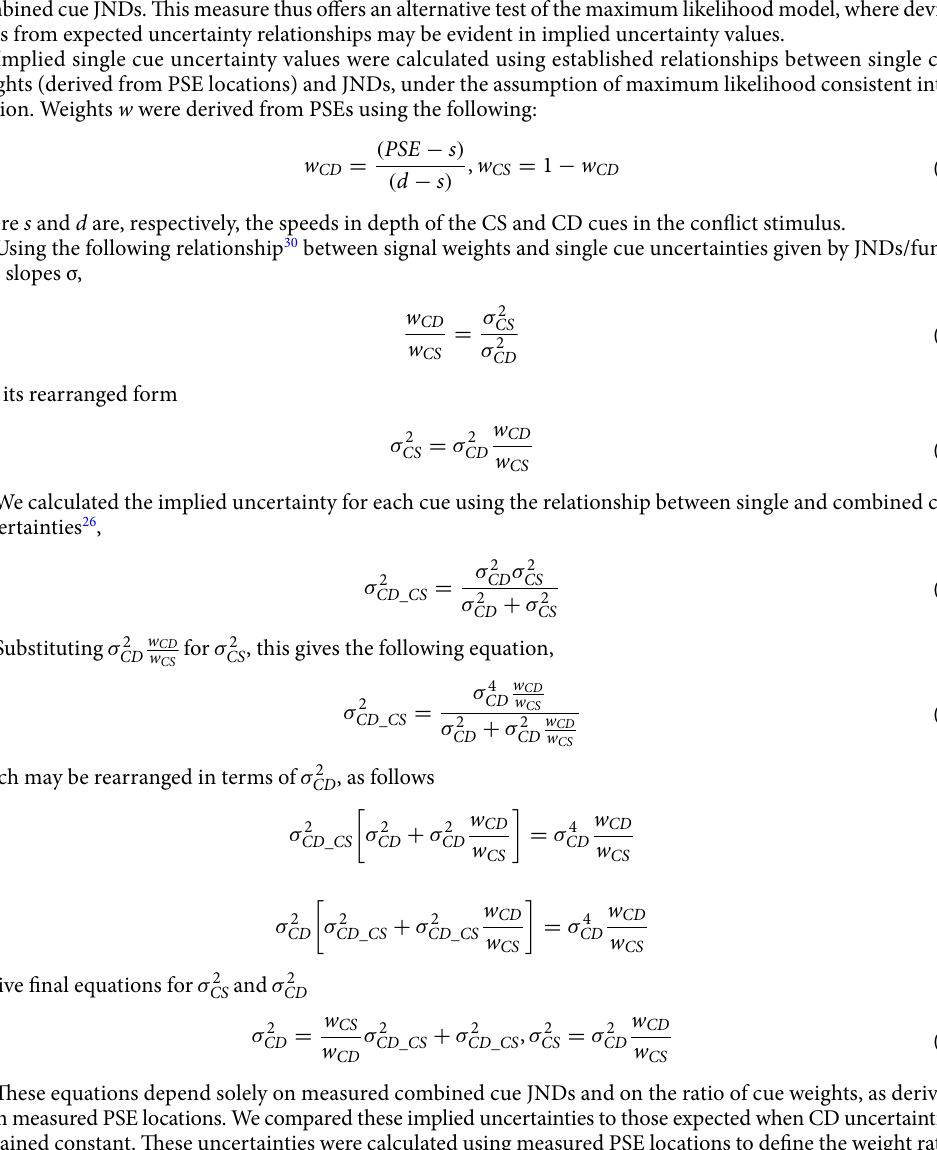
Experiment 2: cue conflict discrimination. Design and procedure. Conflict discrimination was